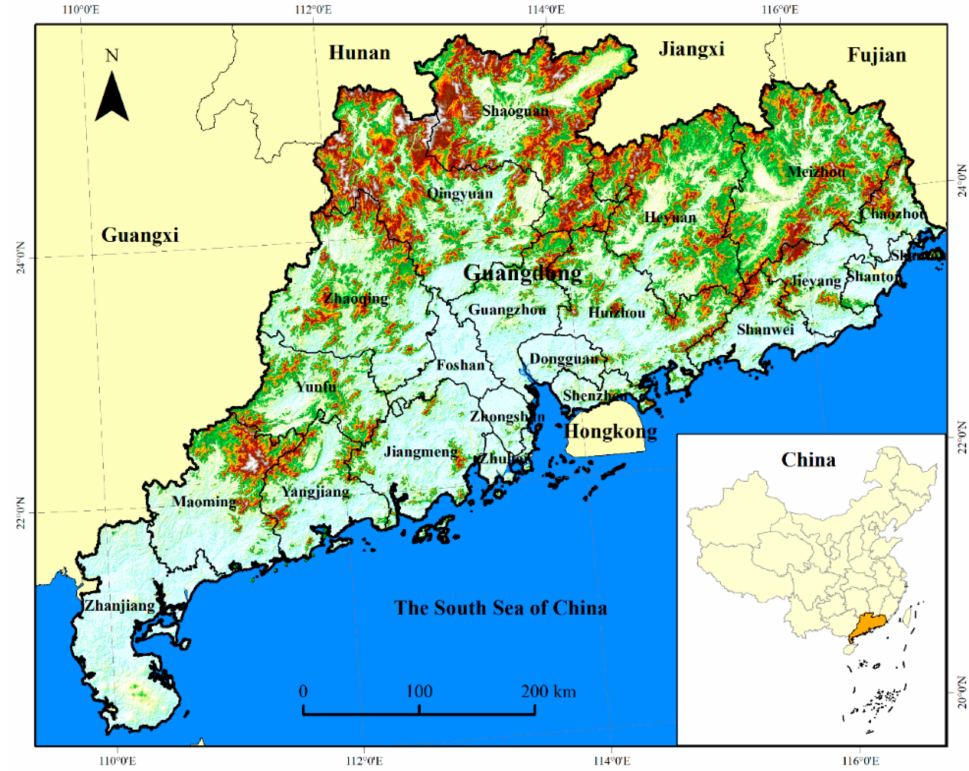
Figure 1. Geographical location of Guangdong province,